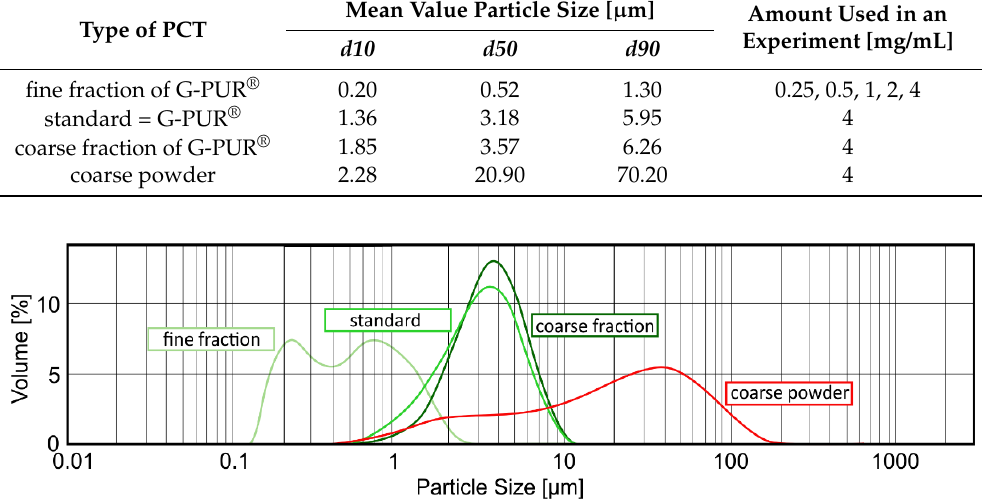
Figure 6. Different particle size distributions of PCT used for gliadin binding. The distribution of various particle sizes was analyzed by Mastersizer 2000 measurement and evaluated with software version 5.31 (Malvern Instruments).